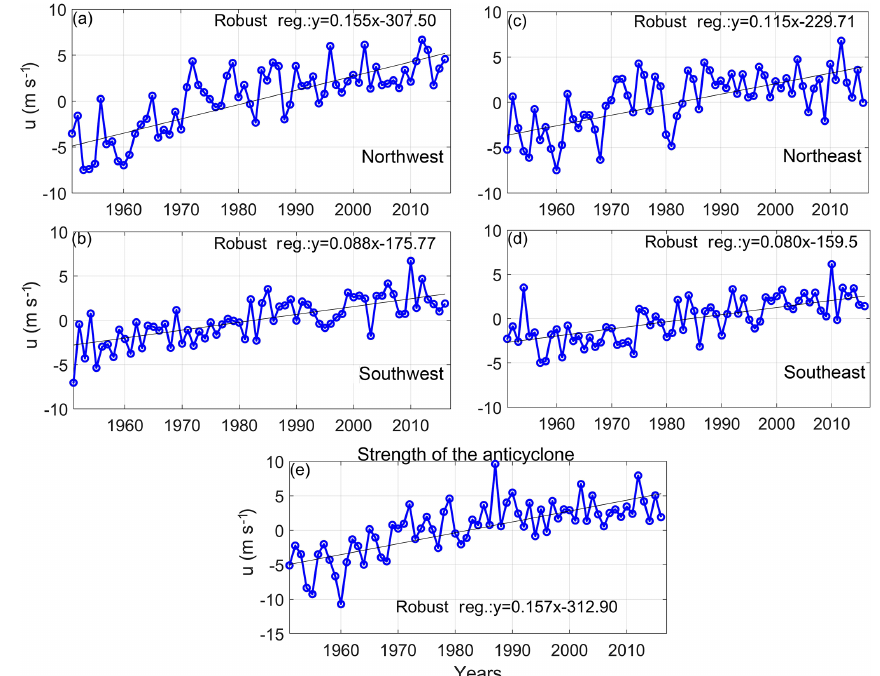
Figure 5. Time series of zonal wind anomalies estimated for the (a) northwest, (b) southwest, (c) northeast and (d) southeast sectors of the ASMA. The trend analysis was performed at a 95% confidence interval using robust regression analysis. (e) The strength of the anticyclone was estimated from the zonal wind difference between 30–40 ◦ N and 10–20 ◦ N in the longitude band from 50 to 90 ◦